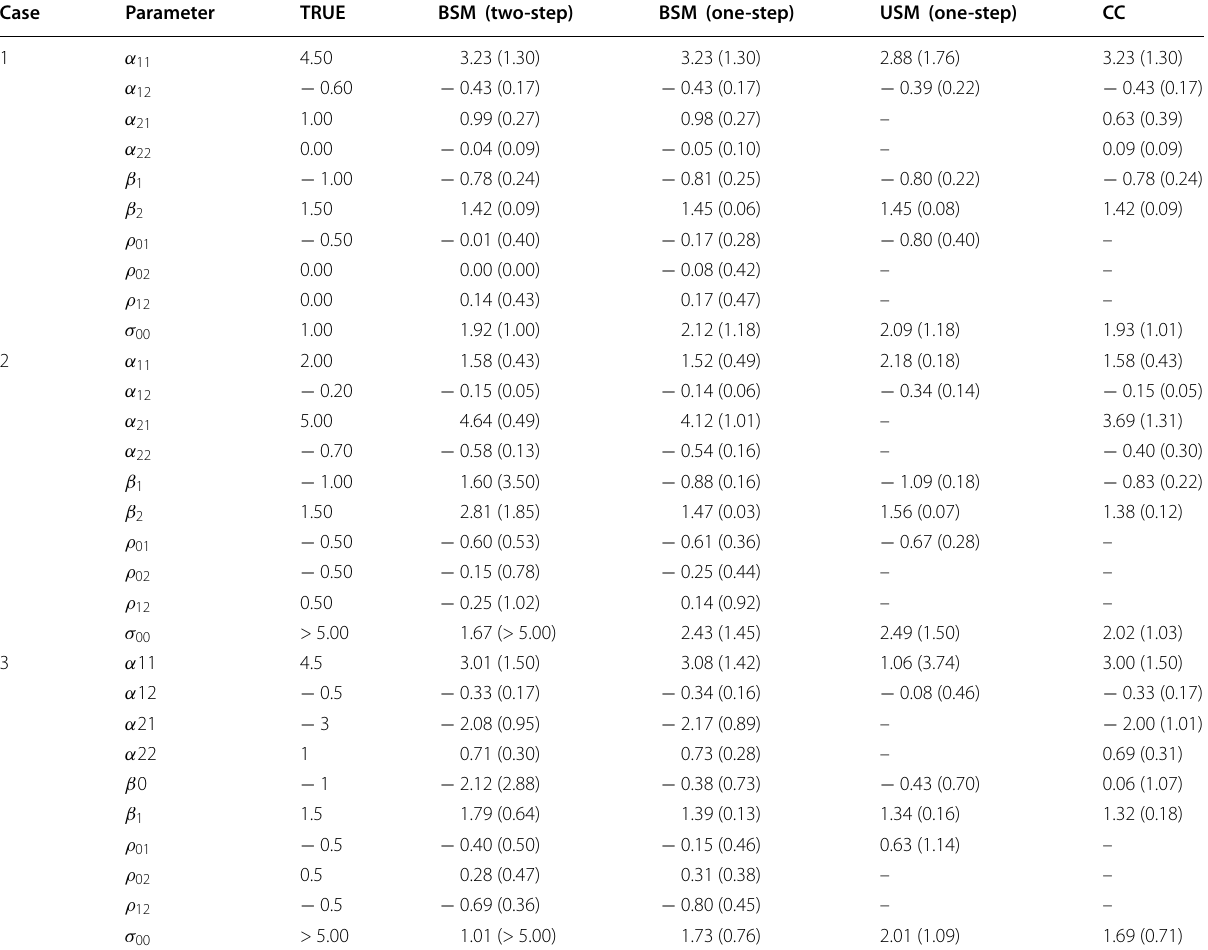
The same as that of Table